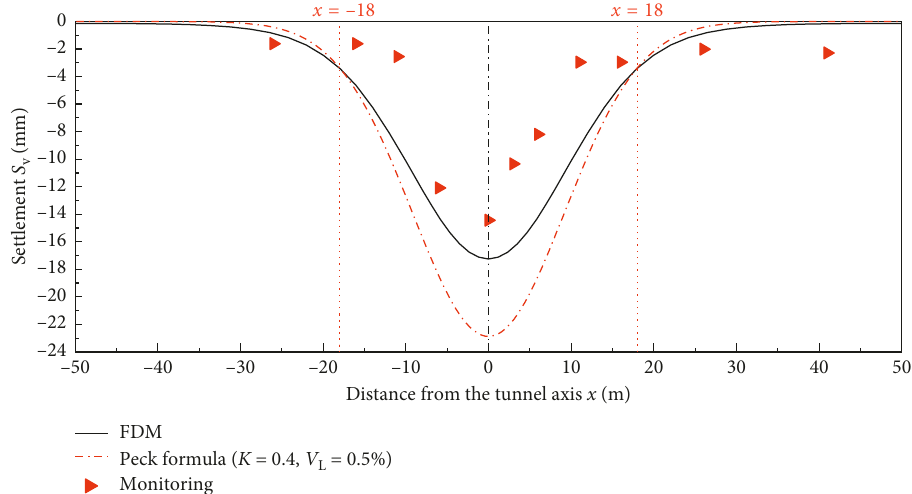
Figure 11: Comparison of the predicted and measured transverse settlement profile (Step